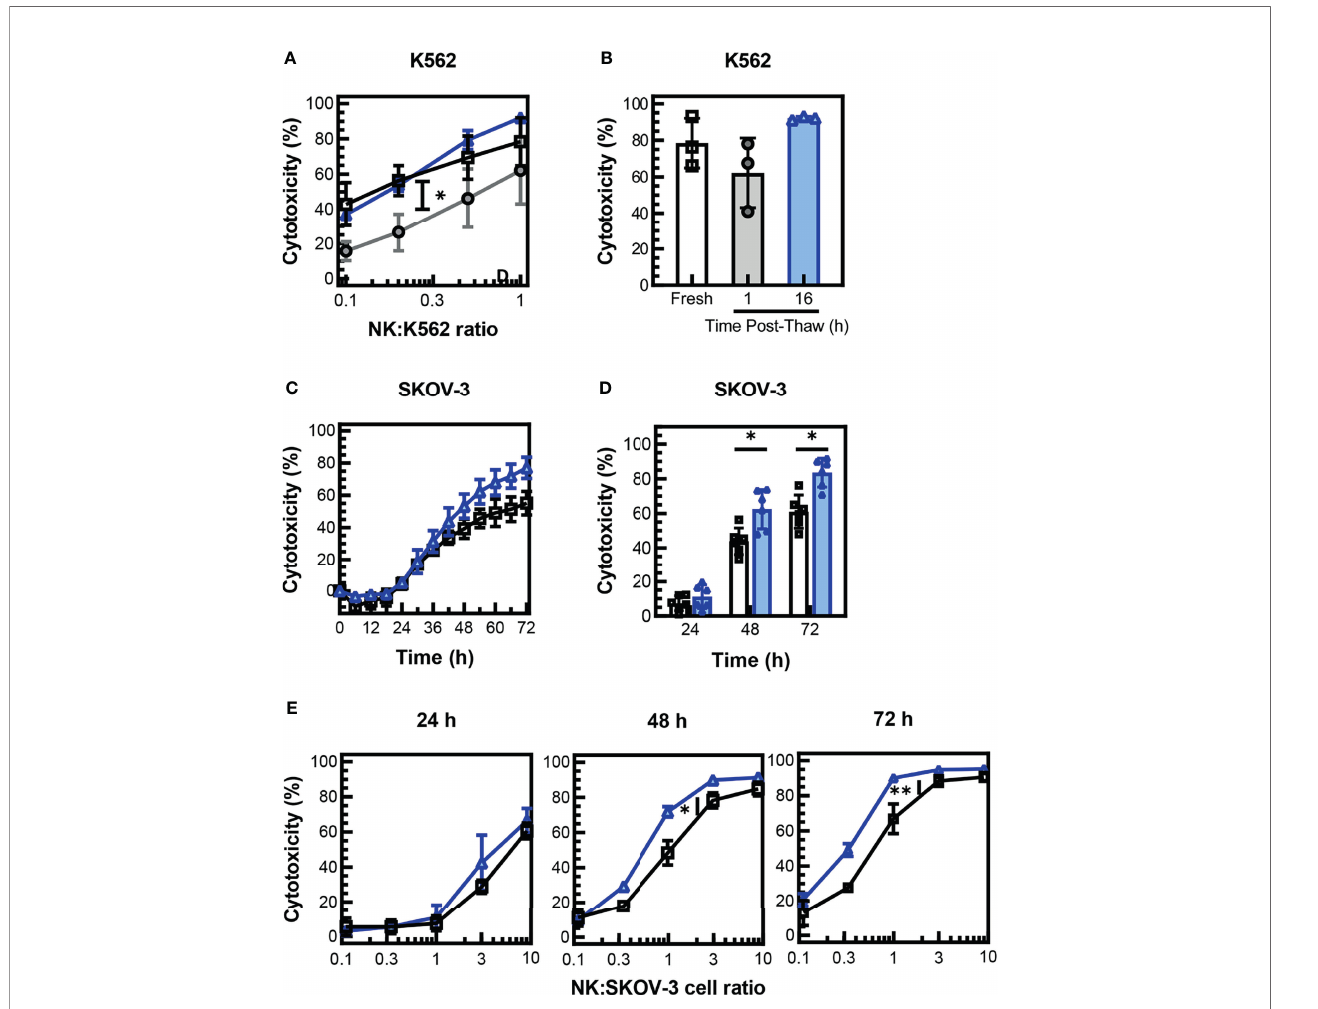
FIGURE 3 | NK cells maintain cytotoxicity against tumor cells after cryopreservation. PM21-NK cells were expanded from T-cell-depleted PBMCs obtained from multiple donors (N = 2 – 3). Cells were cryopreserved while donor-matched fresh PM21-NK cells (black squares) were maintained in culture. Frozen NK cells were thawed and rested 16 h the day before analysis (blue triangles) or thawed and rested 1 h on the day of analysis (gray circles). Fresh or thawed NK cells were added to K562-GFPLuc cells at the indicated NK:K562 ratio (A) or at a ratio of 1:1 (B) and co-incubated for 60 min to measure cytotoxicity using Annexin V assay. Cryopreserved PM21-NK cells were less cytotoxic against K562 cells 1 h post-thaw compared to fresh PM21-NK cells but recovered cytotoxicity when rested 16 h post-thaw (N = 3 donors). (A, B) . Cryopreserved PM21-NK cells that were rested 16 h post-thaw (blue triangles), killed SKOV-3 cells similarly or better compared to matched fresh PM21-NK cells (black squares) (one representative donor in triplicate) (C) . Cryopreserved PM21-NK cells that were rested 16 h post-thaw (blue triangles), killed SKOV-3 cells similarly or better compared to matched fresh PM21-NK cells (black squares) at a 1:1 NK : SKOV-3 ratio (N = 2 in triplicate). (D) Concentration-dependent cytotoxicity curves were generated by measuring cytotoxicity at the indicated time-points of the cytotoxicity assay at multiple NK : SKOV-3 cell ratios (E) . Cryopreserved PM21-NK cells rested for 16 h post-thaw had comparable or increased cytotoxicity compared to donor and expansion-matched fresh PM21-NK cells (N = 2 in triplicate) (E) . Data are presented as scatter plots or bar graphs with error bars representing standard deviation. Statistical signi fi cance was determined by multiple paired t-tests. For cytotoxicity plots, the area under the curve was measured and then statistical signi fi cance was determined by unpaired t- tests. p values are shown as *p < 0.05, **p <